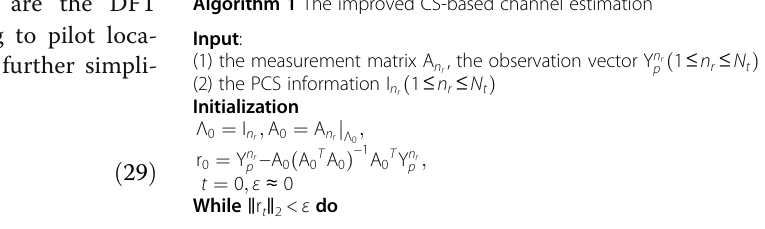
Algorithm 1 The improved CS-based channel